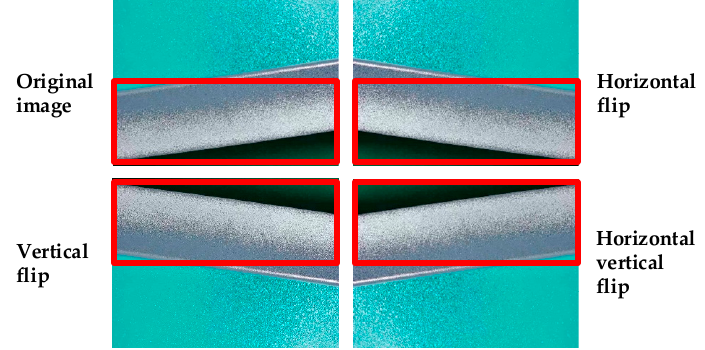
Figure 3. Data augmentation.